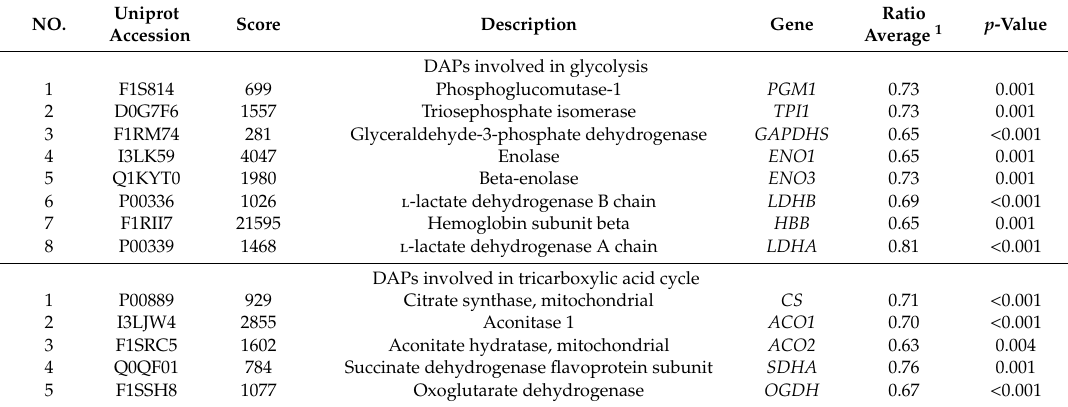
Table 2. DAPs involved in carbohydrate and lipid metabolism, mitochondrial function, steroid hormone biosynthesis, oxidative stress and